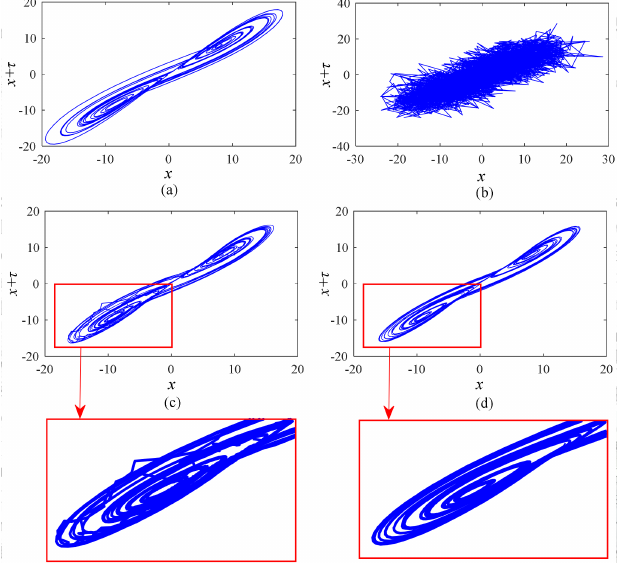
Figure 10. ( a ) Phase diagram of Lorenz without noise. ( b ) Phase diagram of Lorenz with noise. ( c ) Phase diagram of Lorenz after noise reduction by the standard local projection algorithm. ( d ) Phase diagram of Lorenz after noise reduction by multiscale local projection. ( τ =